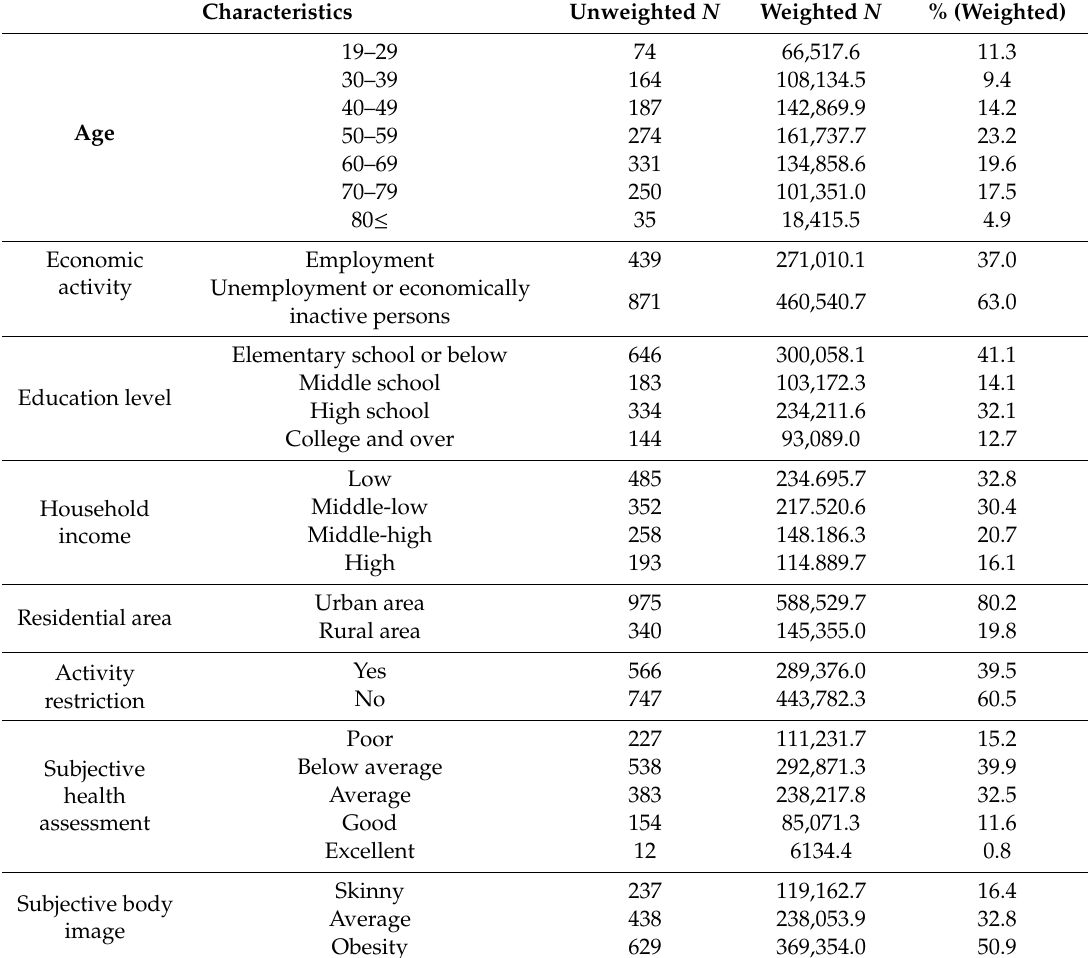
Table 1. Demographic characteristics of participants and adjusted